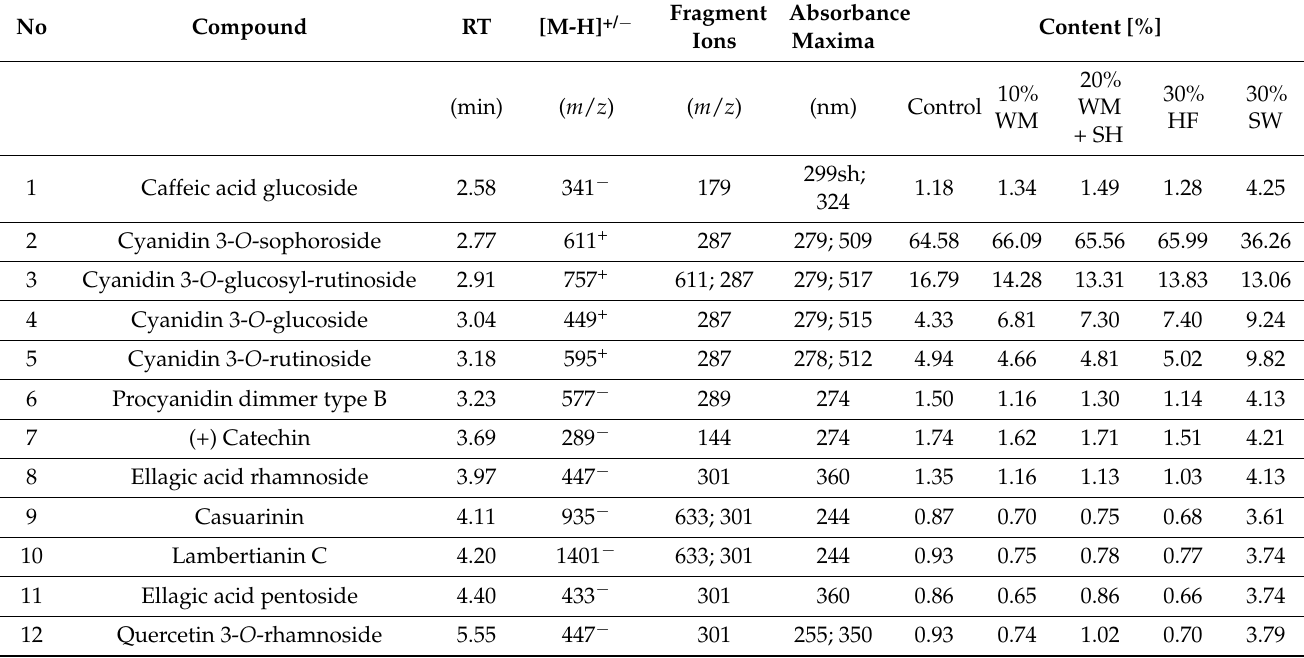
Table 1. Individual phenolic compounds identified by UPLC-PDA-MS/MS in raspberry fruits depending on the substrate used.